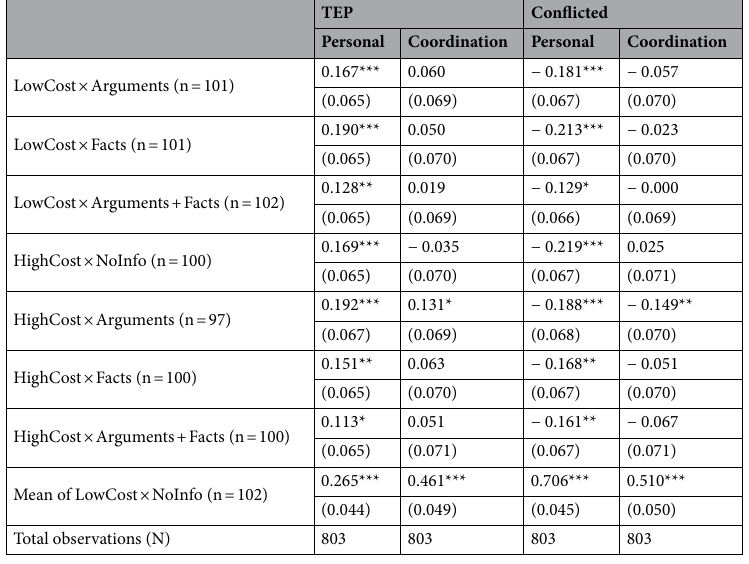
Table 2. Impact of vaccine cost and information conditions. TEP refers to pricing strategy that is tiered across countries, equitable for poorer countries, and profitable for manufacturers. Conflicted refers to conflicted participants who supported some but not all the three components of TEP (tiering, equity, and profitability). Personal decisions are decisions made in the individual task. Coordination decisions are decisions made in the coordination (collective agreement) task. The coefficient estimate for each treatment group is the mean difference between the share of a decision in the treatment group and the share of a decision in the baseline LowCost × NoInfo group. All estimates are based on a multivariate Ordinary Least Squares regression that include all treatment indicators, dummies for sufficient baseline knowledge of factors relevant to vaccine pricing, total quiz score (which measures comprehension of experimental instructions), and an attention check indicator (which controls for whether participants paid attention during the experiment). The means for the baseline LowCost × NoInfo group are reported in the row above the number of observations (N). The sample size in each group is denoted by n. Robust standard errors are reported in parentheses. *** p < 0.01; ** p <